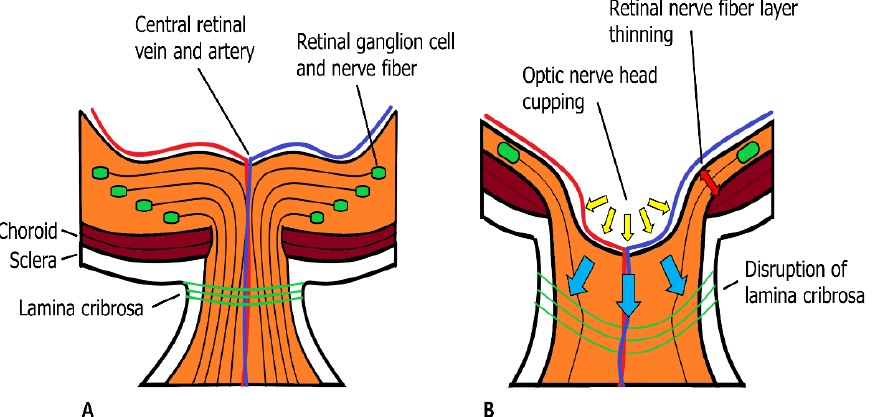
Figure 4. Normal retina and optic nerve head (ONH) ( A ). Retinal ganglion cell (RGC) axon bundle passes lamina cribrosa (LC) and exits the eye. LC supports the RGC axon bundles as they become the optic nerve. Glaucomatous ONH change ( B ). Increased intraocular pressure causes mechanical stress in the LC. Due to mechanical stress in LC, cytokine activity is increased, which induces matrix metalloproteinase (MMP) expression and extracellular matrix (ECM) remodeling in the ONH. Additionally, mechanical stress cause apoptosis of RGC by increased MMP-9 activity. The aftermath of glaucomatous ONH changes includes cupping of ONH (yellow arrows), retinal nerve fiber layer thinning by RGC apoptosis (red double arrow), and lamina cribrosa disruption (blue arrows) [31,95–98,].